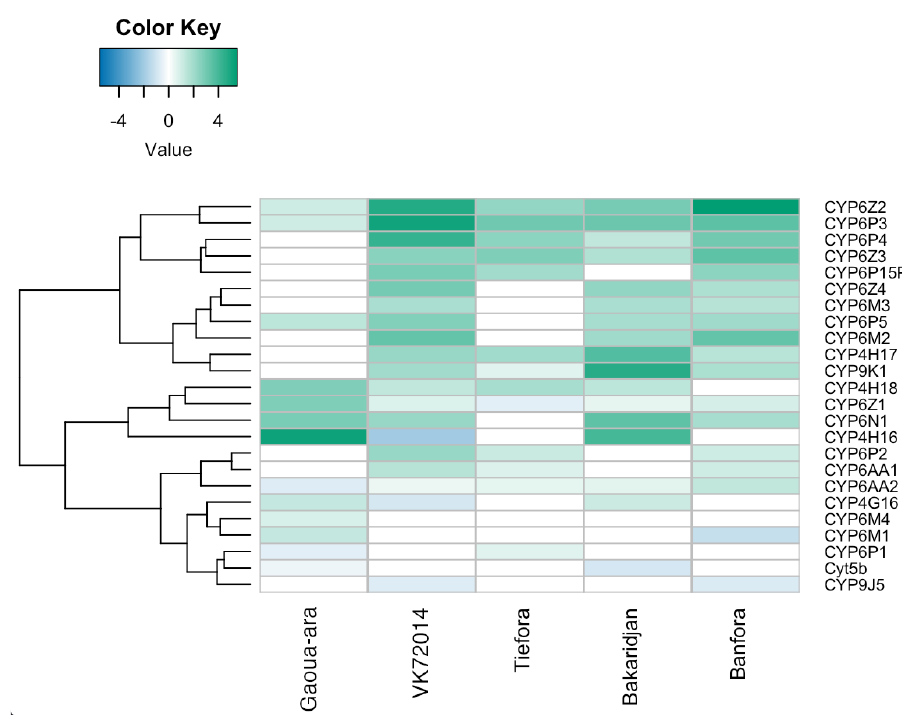
Figure 7. Heatmap showing cytochrome P450 genes that are significantly differentially expressed between the pyrethroid resistant and susceptible strains. Recently, a number of genes with putative roles in sequestering pyrethroids were found to be over expressed in pyrethroid resistant populations from West Africa [37].